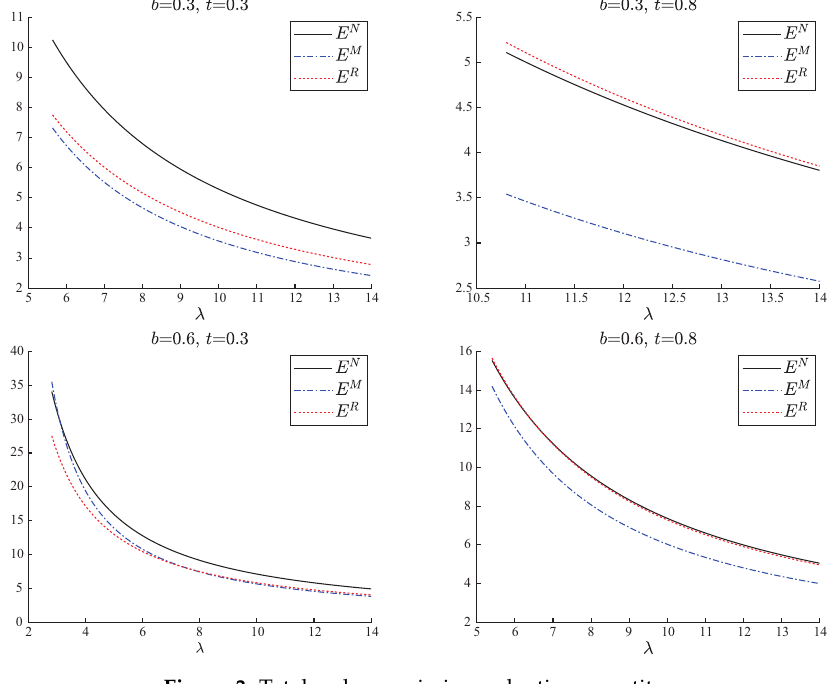
Figure 3. Total carbon emission reduction quantity.